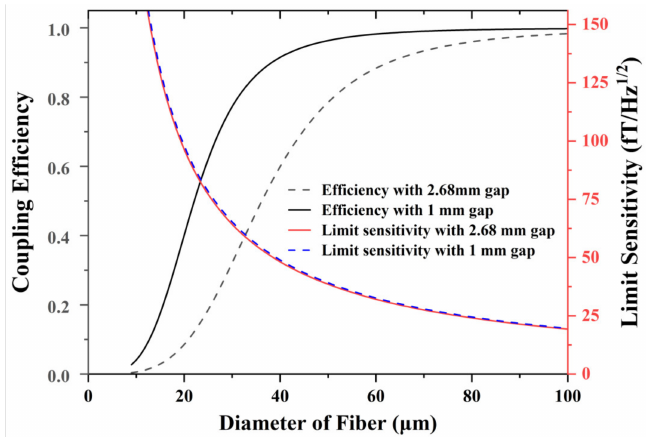
Figure 5. The coupling efficiency with the diameter of the fiber.